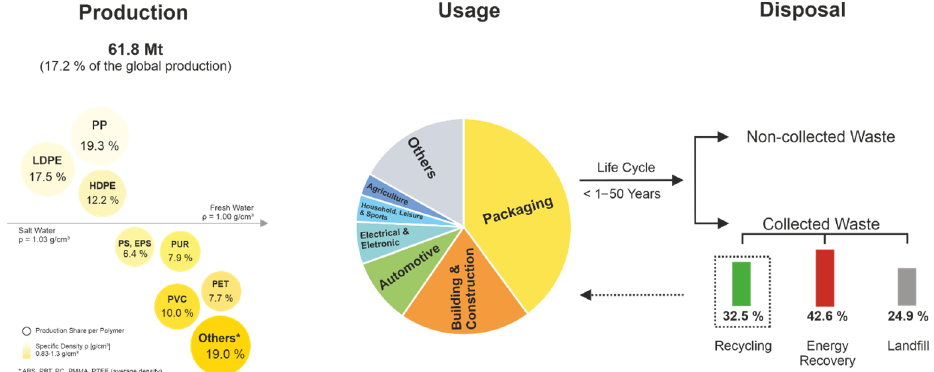
Figure 2. Life cycle of macroplastic with characteristic information on production shares, specific specific densities, market sectors, and waste treatment in Europe 2016 / 2017 (data based on [42], densities, market sectors, and waste treatment in Europe 2016/2017 (data based on [42], layout from layout from [43]).